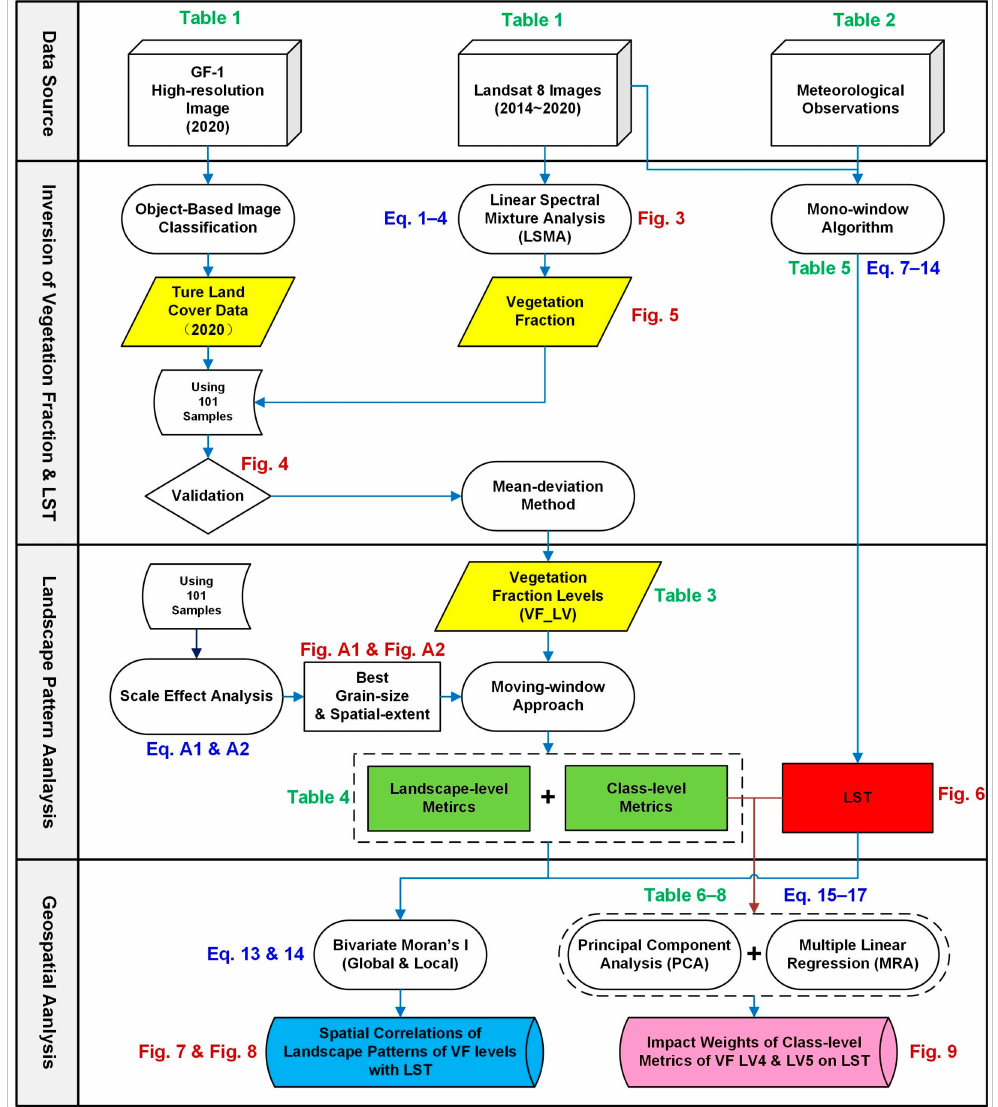
Figure 1. Technical roadmap of this